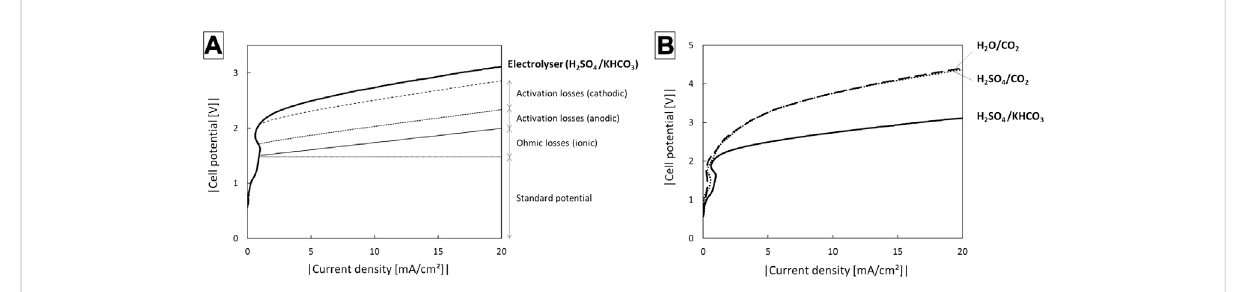
FIGURE 7 Electrolyser potential using differentelectrolyte compositions in theanodeand cathode compartmentsof the three compartment electrolyser with IrO 2 /C anode.